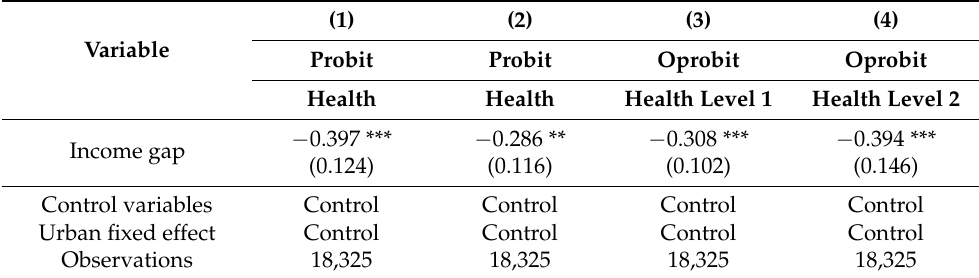
Table 6. Impact of different income gap indicators on health level of rural residents (Measured by Consumption